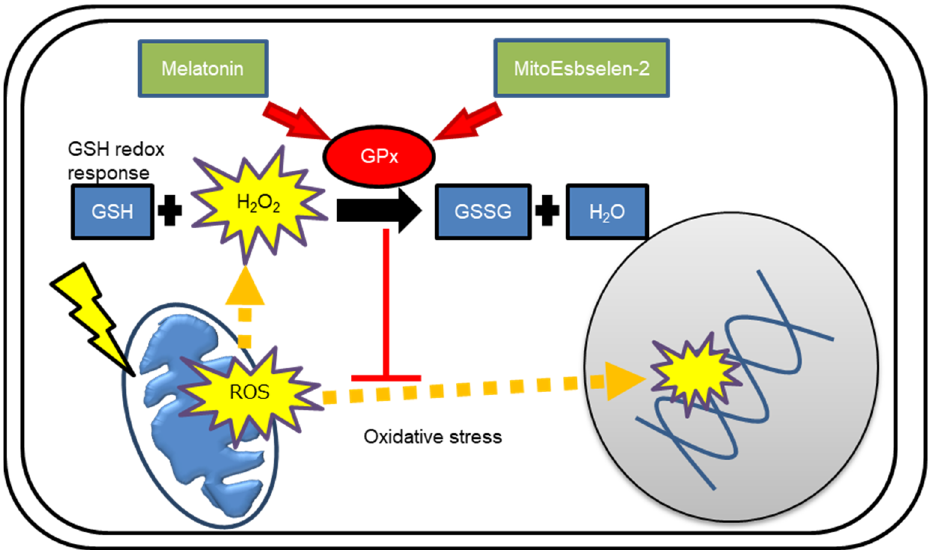
Figure 6. Schematic representation of role of melatonin or MitoEbselen-2 on GPx-mediated redox control